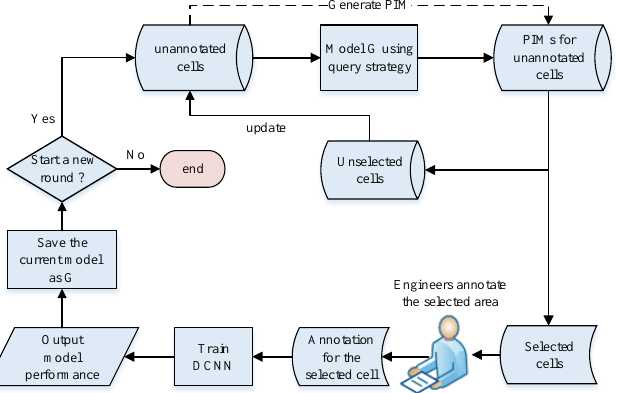
Figure 10. Annotated cell expansion process based on active learning.